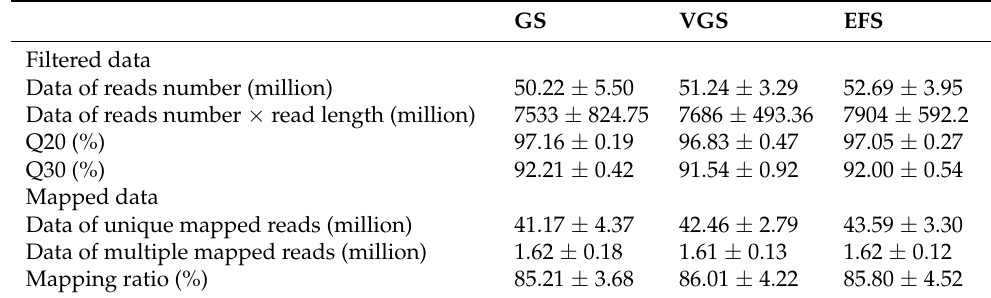
Table 1. Summary of sequencing data of C. songaricum at GS, VGS, and EFS (mean ± SD, n = 3).